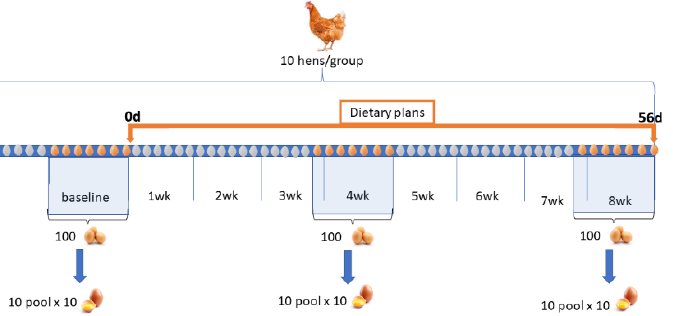
Figure 1. Dietary plan of the experimental trial. Nine eggs/group/day, for a total of 66 days (10 days before dietary administration + 56 days experimental period) were collected. One hundred eggs from 0 (baseline), 4, and 8 weeks were stored and pooled (10 pools of 10 eggs) for analytical deter- mination.